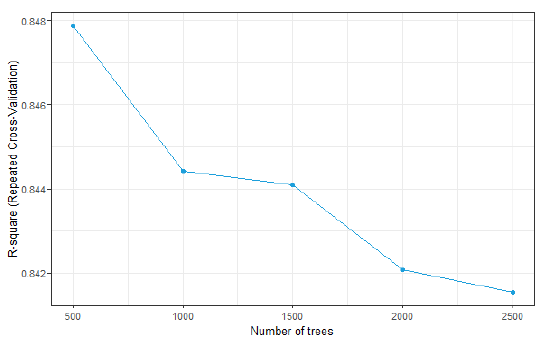
Figure 7 . Grid search for number of trees (ntree)